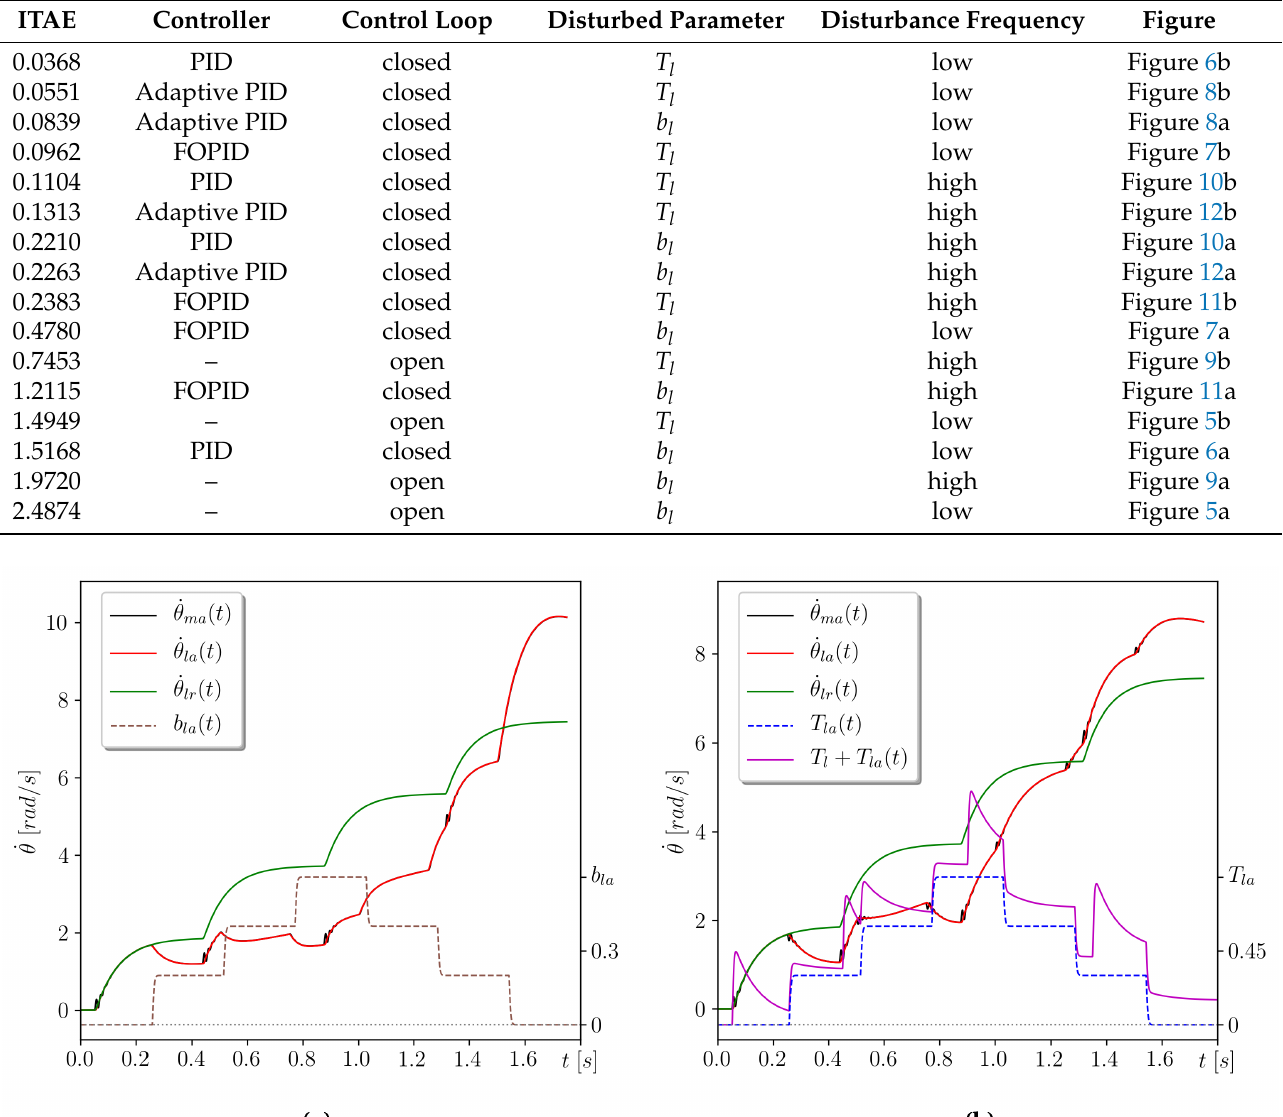
Table 2. The Integral Time-Weighted Absolute Error (ITAE) performance index for various numerical experiments.